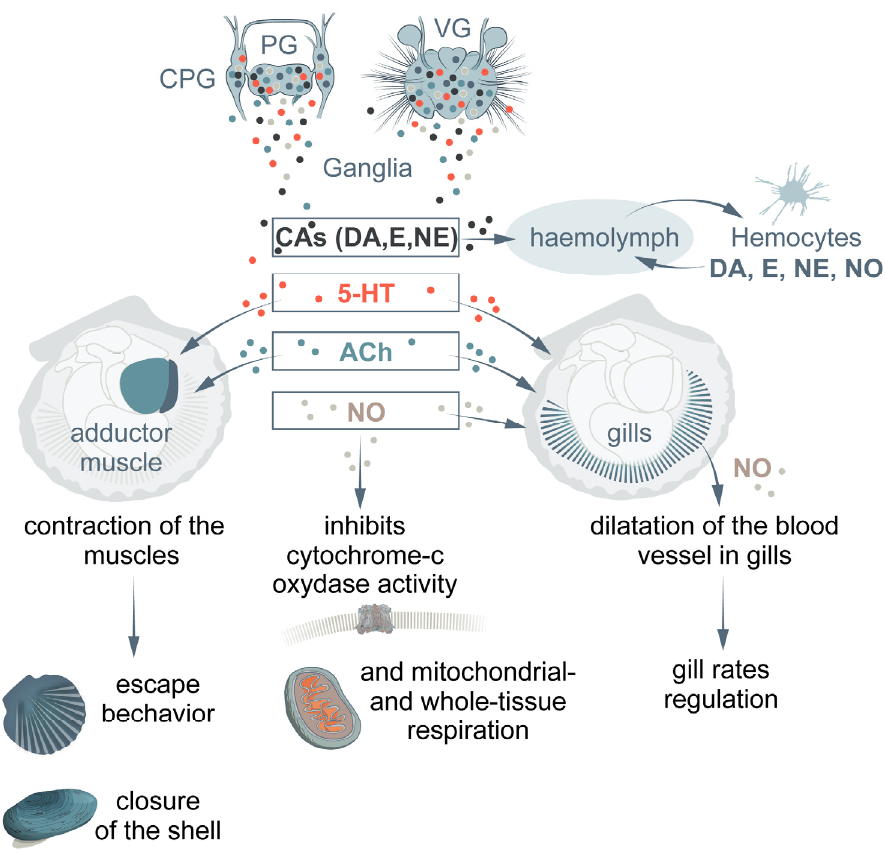
Figure 3. Diagram summarizing available data on the hypoxia stress control and the role of neuro- endocrine regulation in the hypoxic response in bivalves. The involvement of CAs, 5-HT, ACh, and NO under hypoxic conditions is shown.